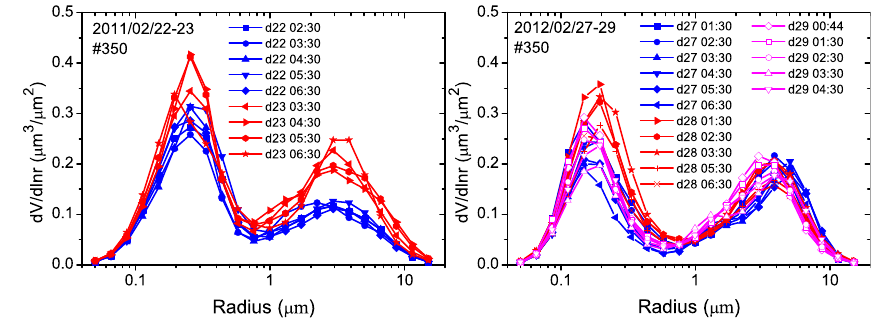
Fig. 6. Aerosol size distribution (d V /dln r ) retrieved on haze day (left, 2011 event; right, 2012 event).